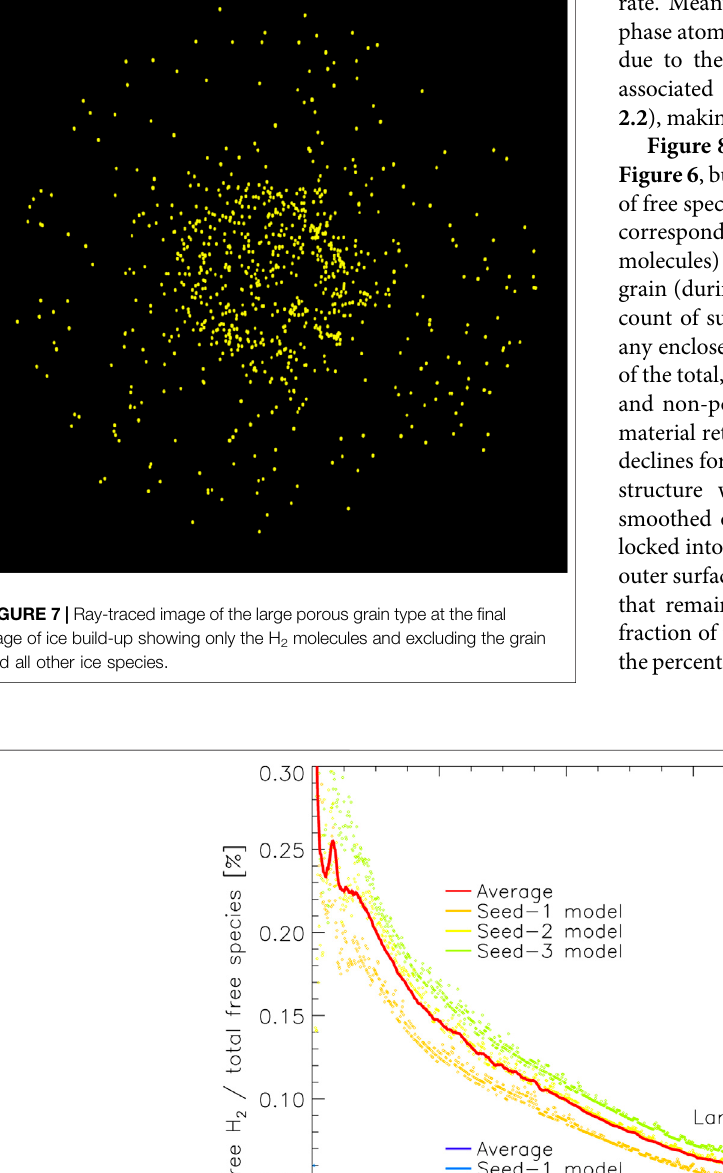
Frontiers in Astronomy and Space Sciences |